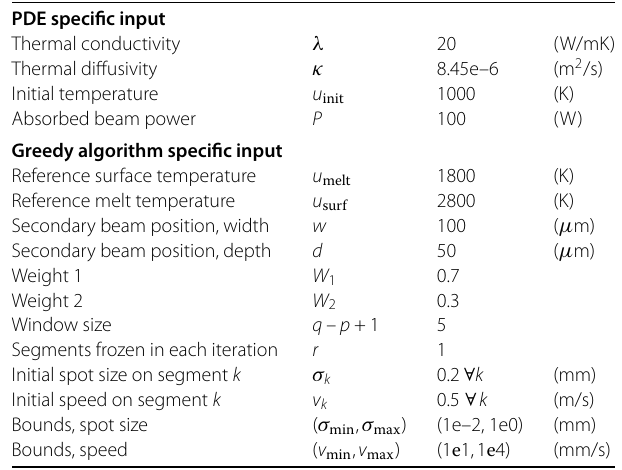
Table 1 Parameter values in Example